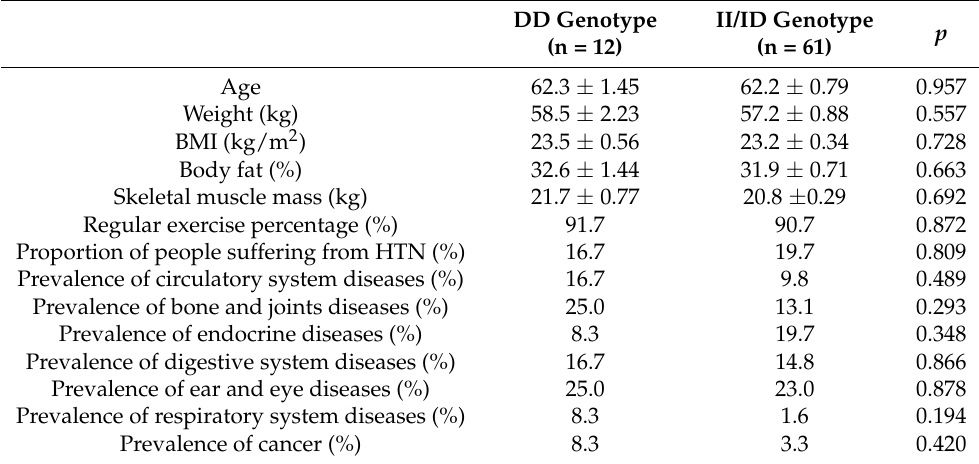
Table 1. Characteristics of the participants (n = 73).